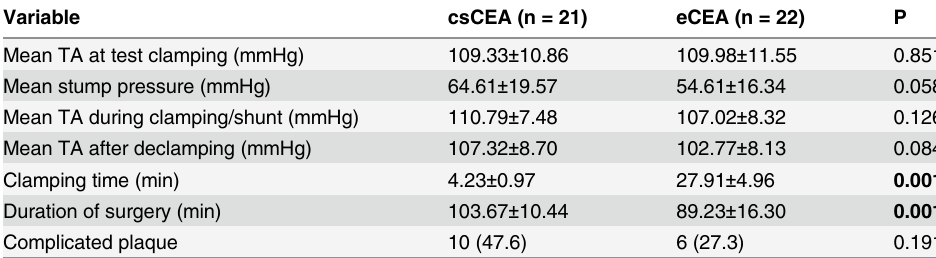
Table 3. Intraoperative variables of patients undergoing